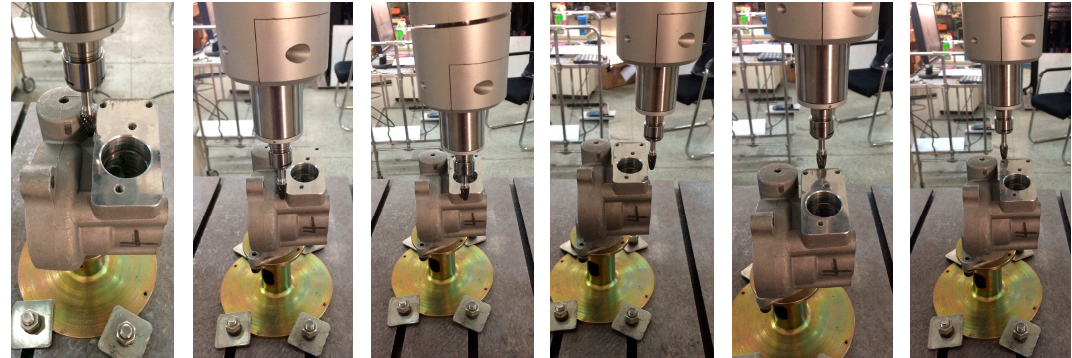
Figure 23. Experimental deburring of facet edges on top facet.